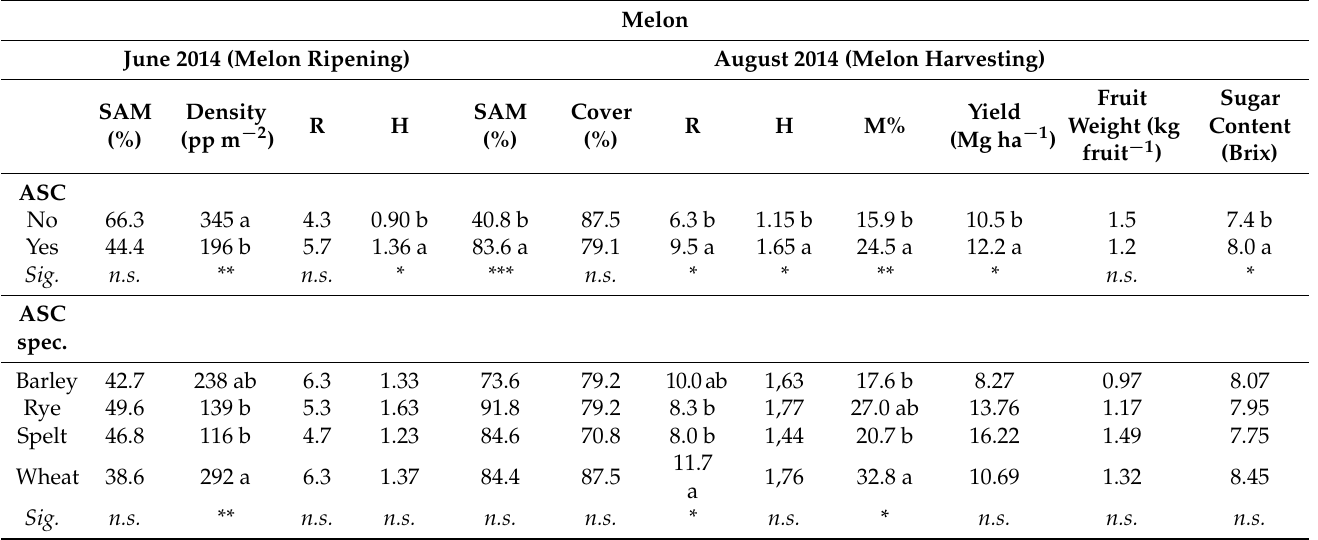
Table 2. Frequencies of species with confirmed mycorrhizal association (SAM%), weed density (pp m − 2 ), weed cover (%, on m − 2 ), species Richness (R), Shannon–Weaver index (H), mycorrhizal colonization intensity of melon (M%), melon yield (Mg ha − 1 ), average fruit weight (kg fruit − 1 ), melon sugar content (Brix), recorded in 2014 at melon ripening and/or at melon harvest. ASC: agroecological service crop. Levels of statistical significance (p-value) are: * p < 0.05, ** p < 0.01